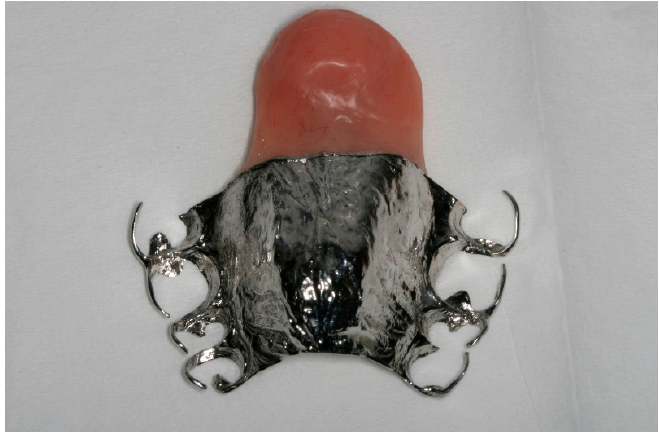
Figure 2. The constructed definitive prosthesis and palatal speech bulb.